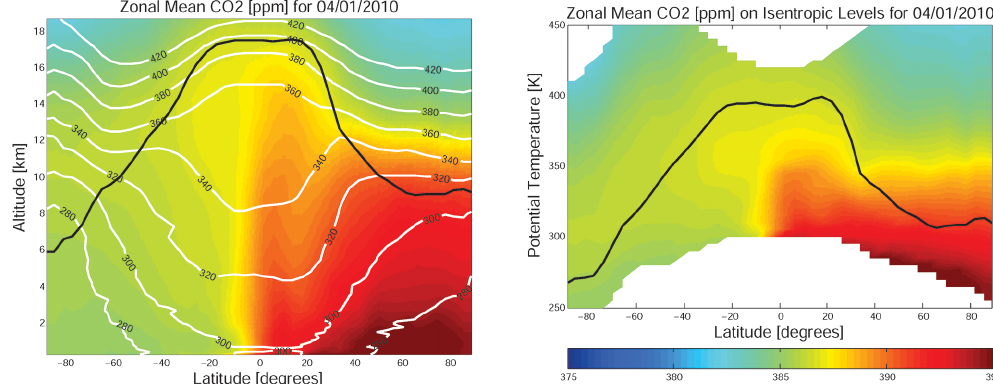
Figure 1. Zonal mean CO 2 from GEOS-Chem on 1 April 2010, as a function of latitude and altitude (left) and latitude and potential temperature (right). In the latitude/altitude plot (left), the white lines indicate the zonal mean potential temperature in Kelvins (K). The thick black line in both plots denotes the location of the tropopause in the